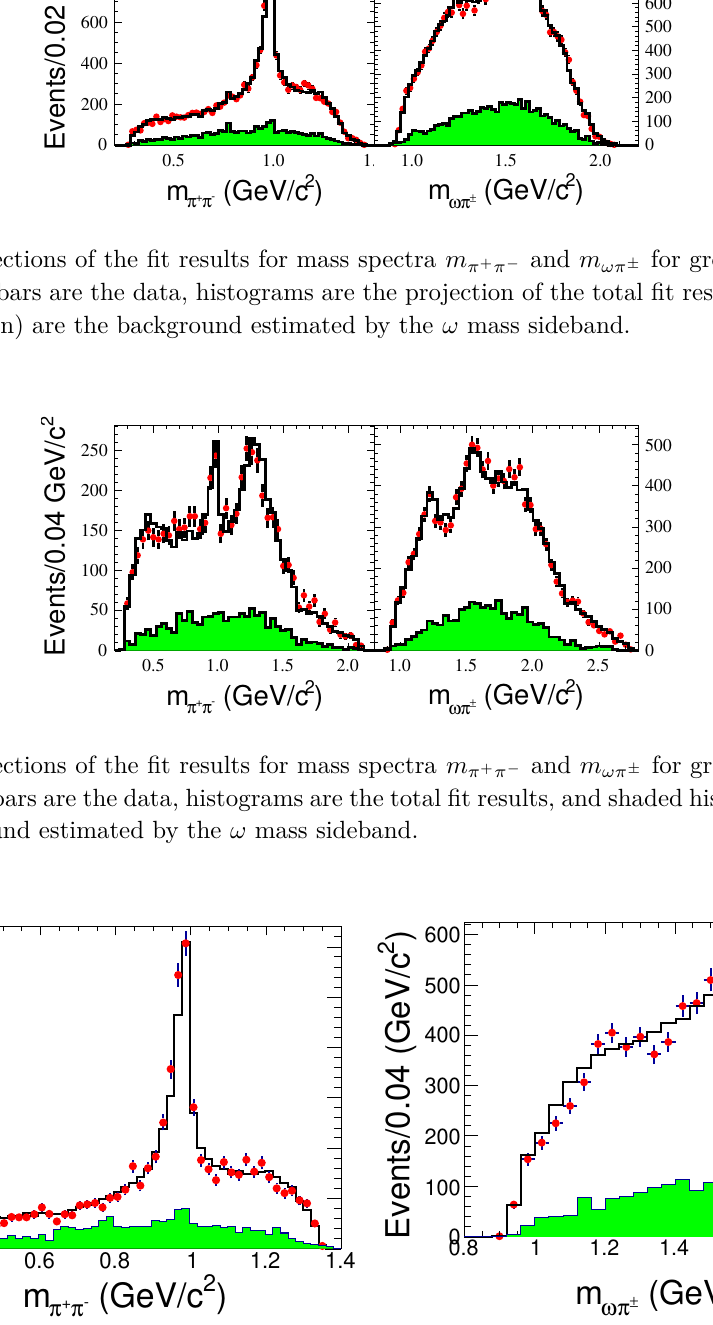
and m mass spectra between data and MC simulation at Figure 6 . Comparison of m π + π − ωπ ± √ s = 2.1250 GeV. Dots with error bars are the data, histograms are the MC simulation, and shaded histograms (green) are the background estimated by the ω mass